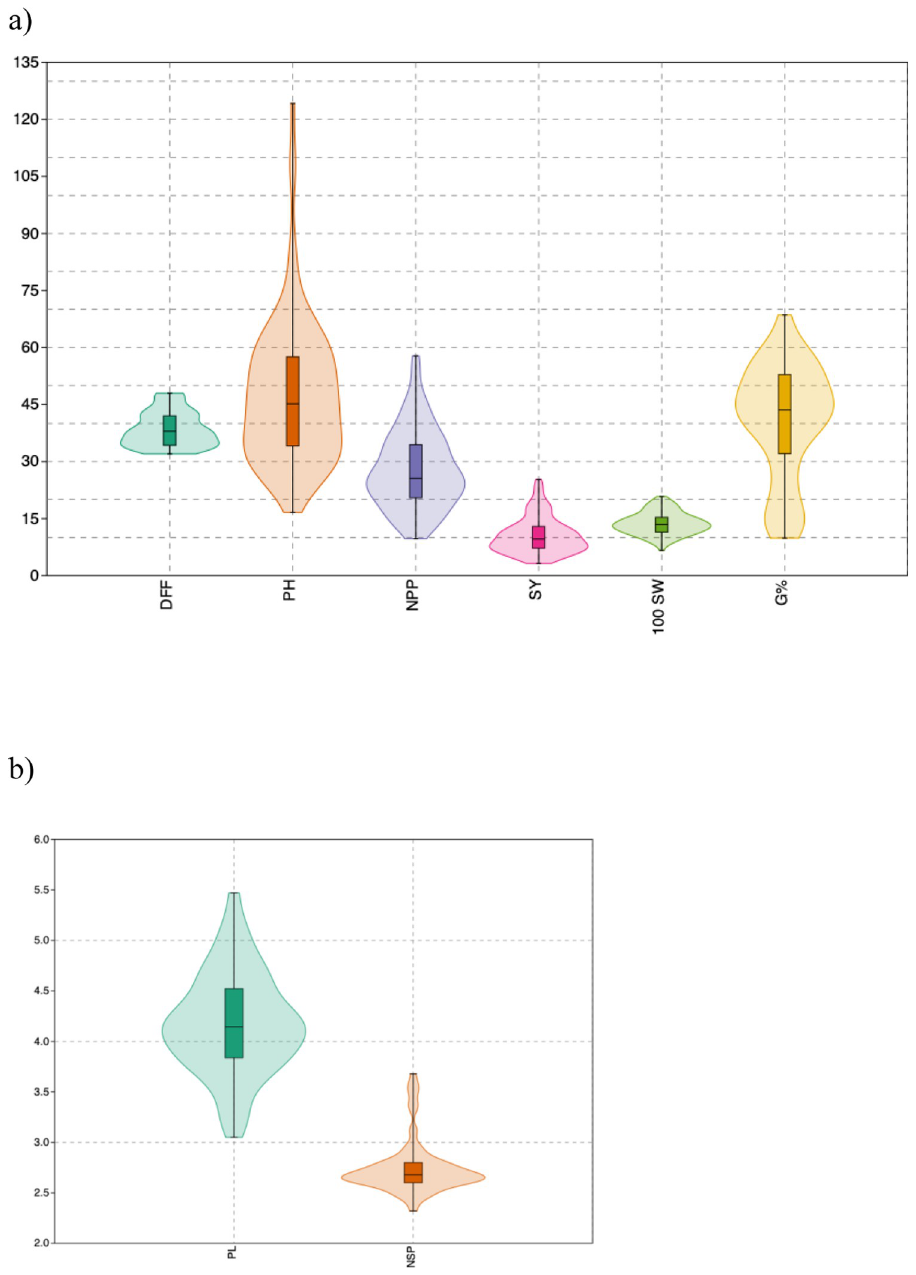
Fig 6. Violin plot of quantitative traits. a) Plot of Days to flowering (DFF), Plant height (PH), Number of pods per plant (NPP), Seed yield (SY), 100 Seed weight (100SW) and Seed longevity (G%) b) Plot of Pod length (PL) and Number of seeds per pod